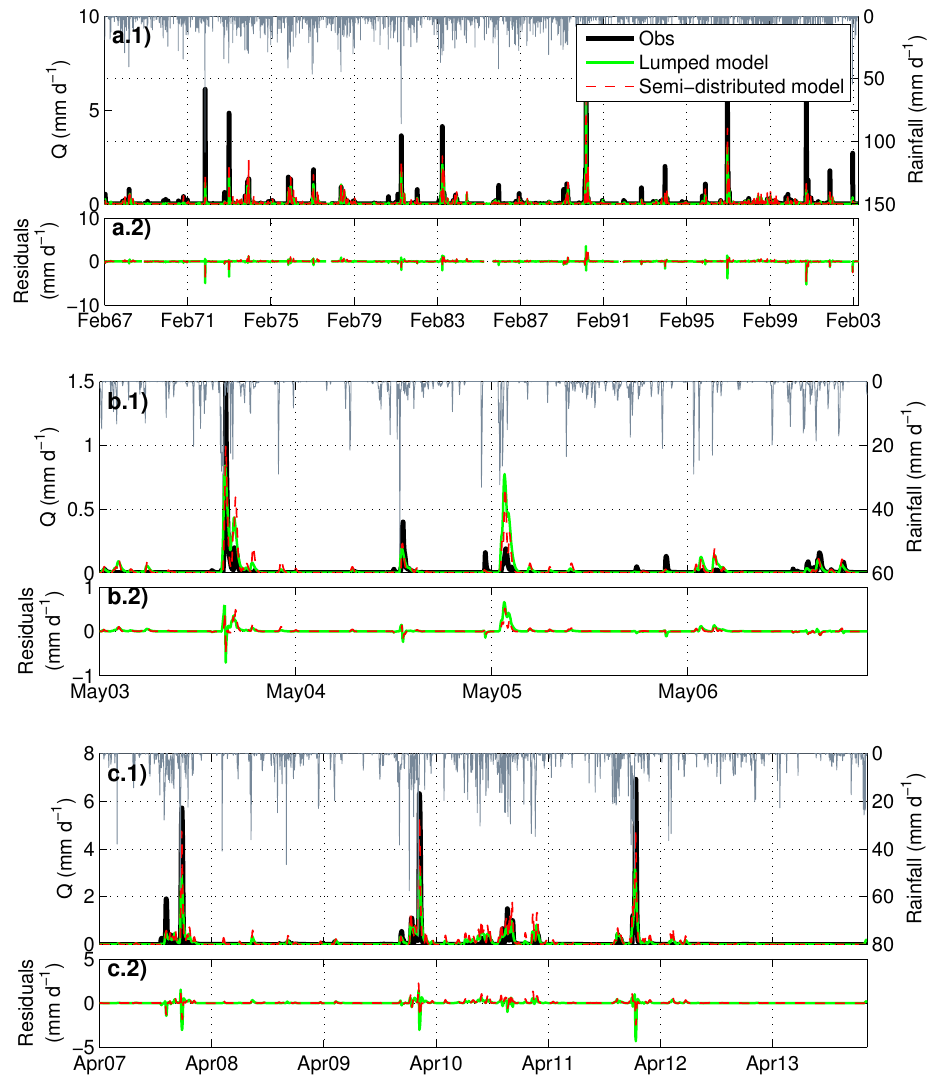
Figure 4. Simulated and observed daily streamflow ( Q ) and model streamflow prediction residuals (simulated minus observed) at the catchment outlet (N7). (a.1) and (a.2) present the calibration period. (b.1) and (b.2) present evaluation sub-period 1, which has only moderate and minor flood events. (c.1) and (c.2) present evaluation sub-period 2, which has 3 major flood events. The daily rainfall plotted on the right axis correspond to the averaged rainfall over the entire catchment.